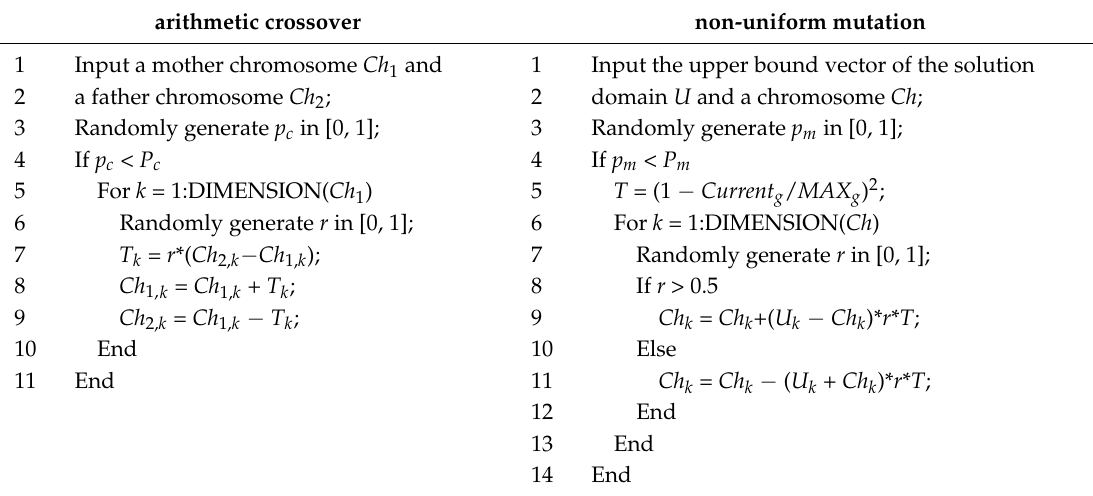
Algorithm 2. The pseudo code of arithmetic crossover and non-uniform